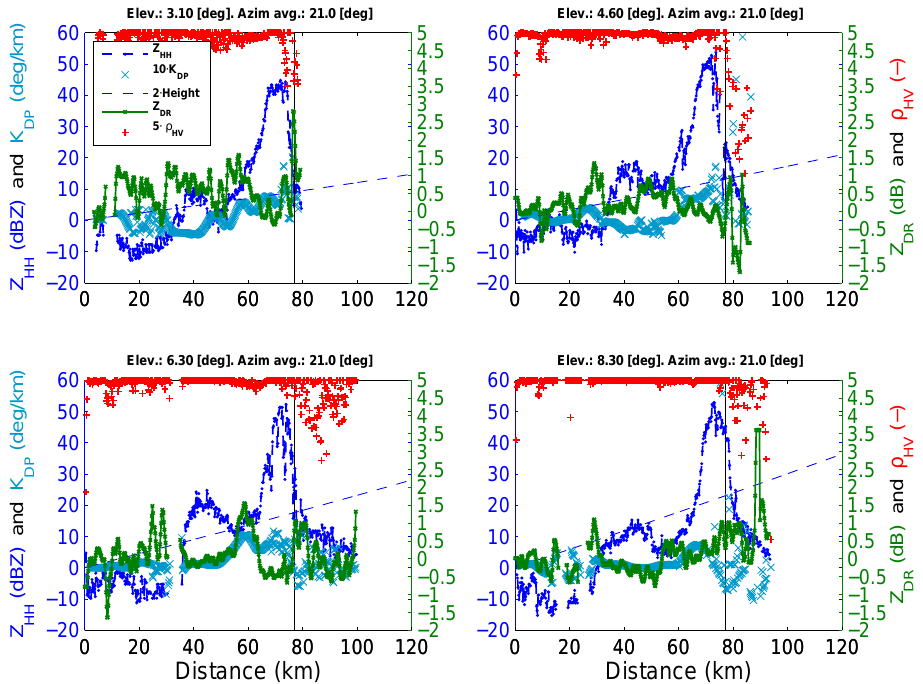
Fig. 6. Range profile of radar variables for four elevations angles as specified in the legend and in the title of each panel, respectively. The azimuth is fixed at 21deg. Profile refers to the DPX radar acquisition at 07:12UTC on 22 May 2011 at the Grímsvötn site. The vertical grey line indicates the position of the Grímsvötn volcano. The values of Z HH and K DP have to be read on the left axes of each panel. Right axes refer to values of ρ HV and Z DR . The height of the radar ray as a function of distance is also shown by dashed line, and its values are on the left axes. K DP and ρ HV and radar ray heights are amplified by a constant factor of 10, 5 and 2, respectively, to appreciate their variations